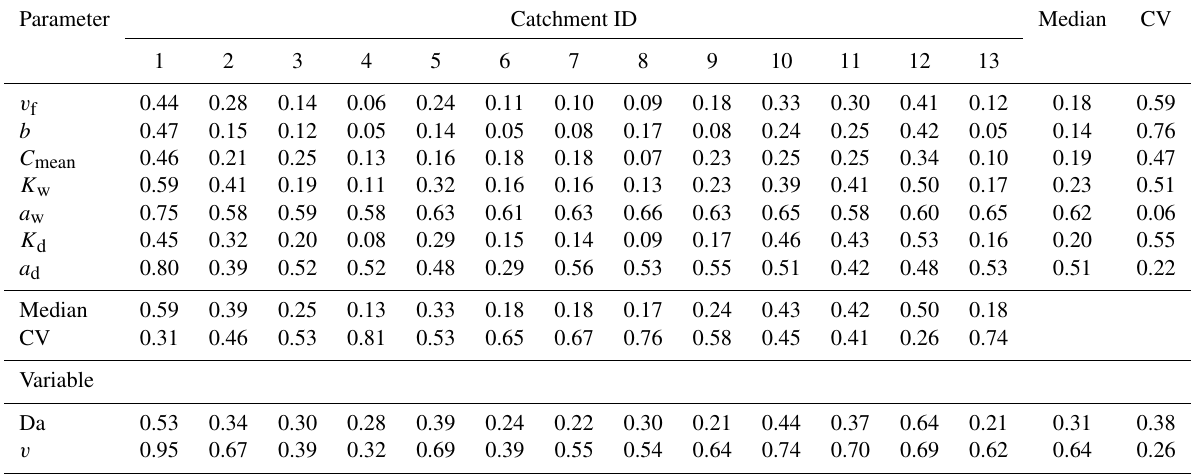
Table C2. PAWN sensitivity indices KS max for all the parameters and all the catchments, together with median and coefficients of variation (CV).